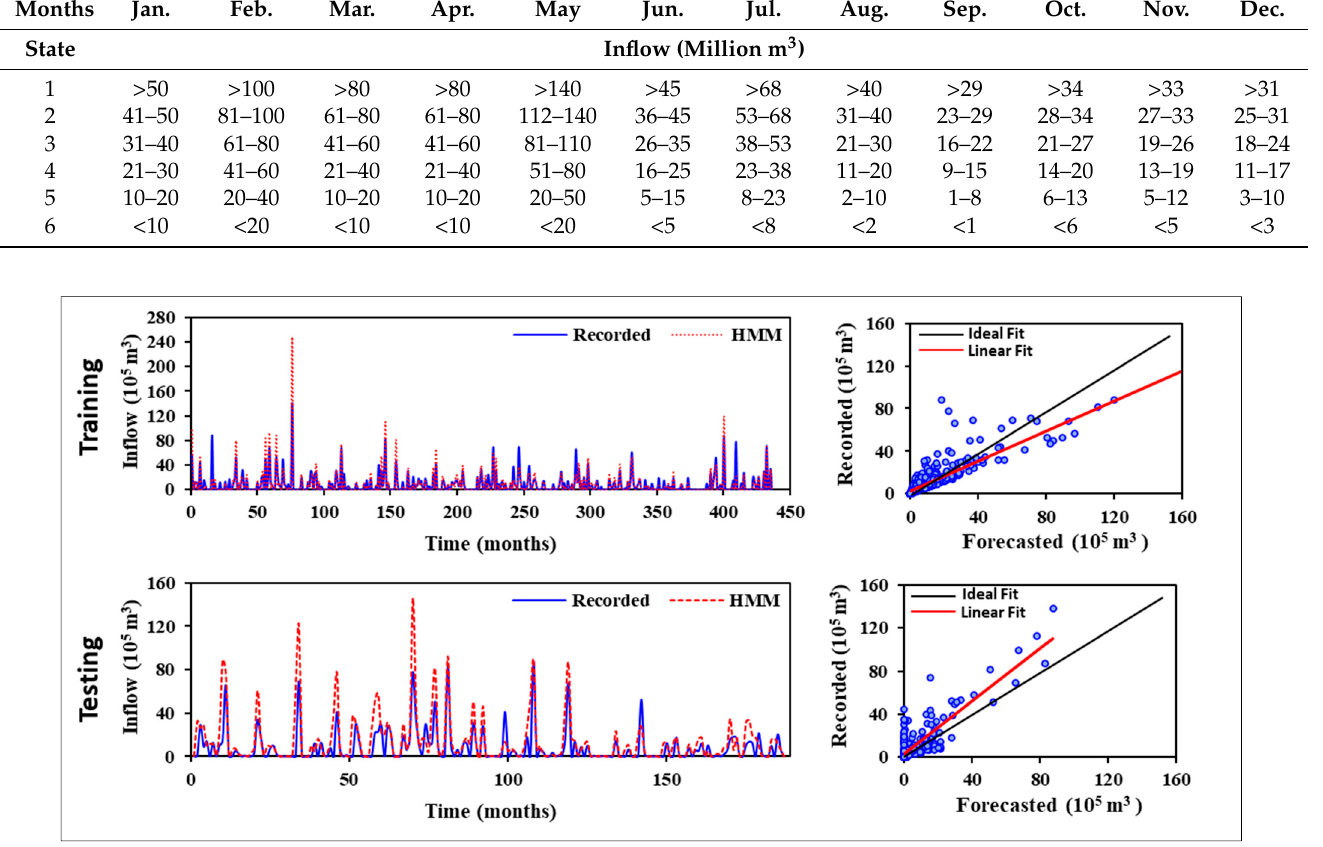
Figure 8. Training and testing results of the simulated monthly inflow based on HMM. Table 2. Performance criteria of the developed models for inflow